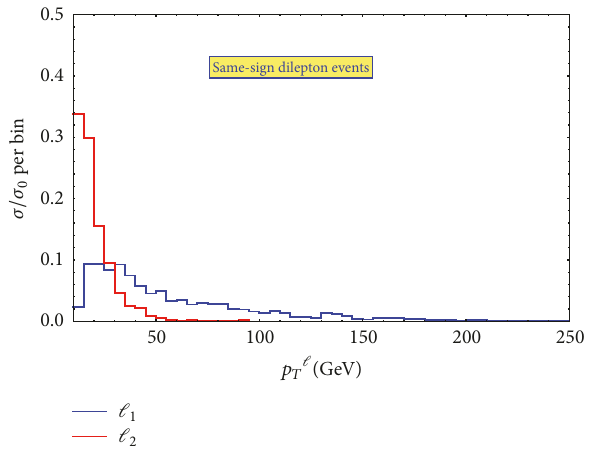
Figure15:Transversemomentumdistributionsofleptons (𝑝 ℓ 𝑇 ) from the same-sign dilepton plus di-jet final state events.